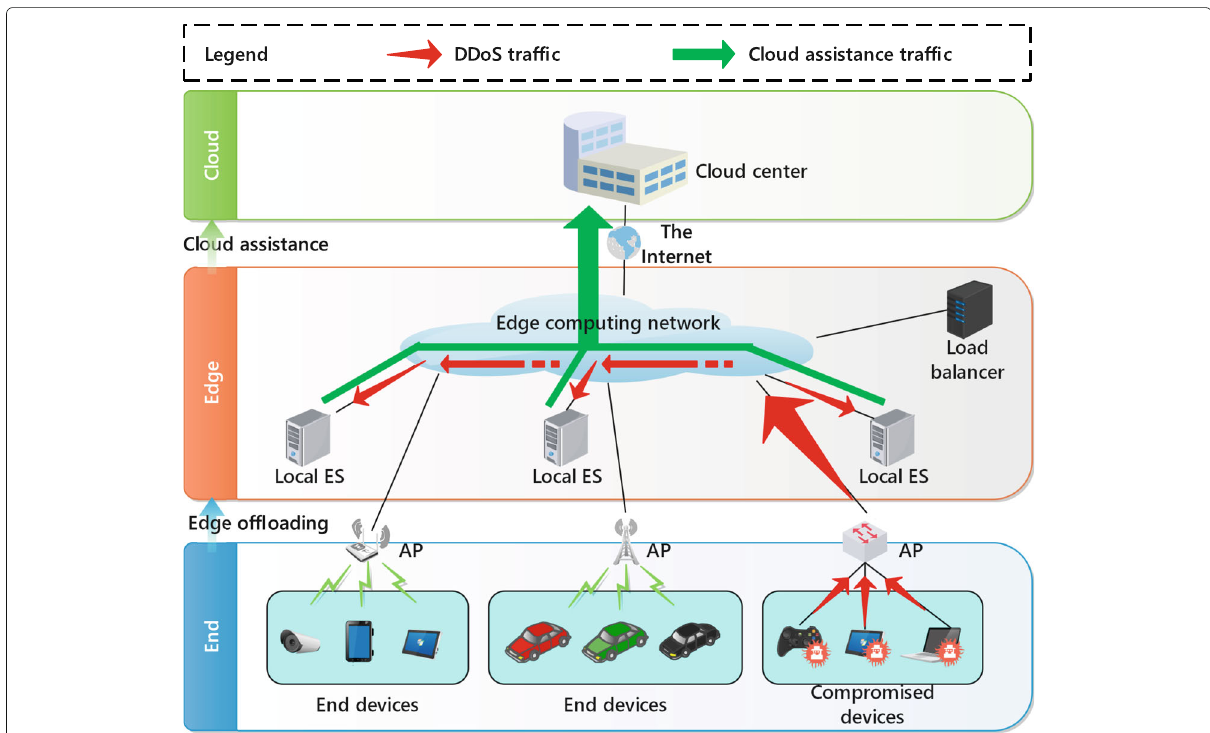
Fig. 2 A diagram of how an EEC ecosystem can mitigate an edge DDoS attack. The DDoS traffic, on the one hand, will be distributed among local edge servers owing to the load balancer, on the other hand, will be uploaded onto the cloud center owing to the cloud assistance